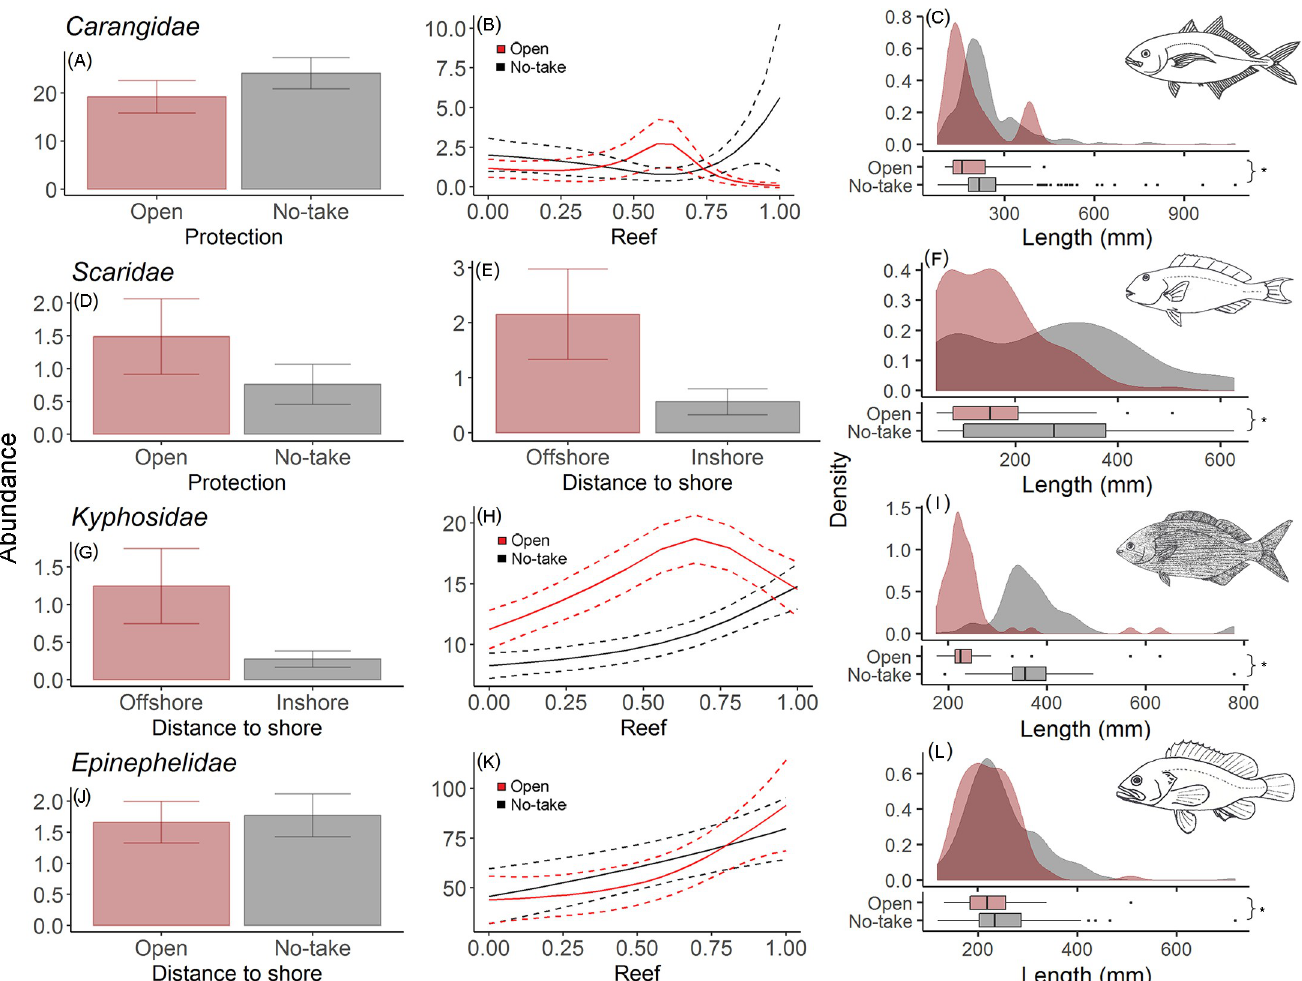
Fig 6. Plots of the most parsimonious models for abundance, Kernel density plots and boxplots for fork length (mm) for important fishing target families. (A, B,C) Carangidae, (D,E,F) Scaridae, (G,H,I) Kyphosidae and (J,K,L) Epinephelidae. The dotted line represents 95% confidence interval. � Significant difference. Fish drawings were based on Carvalho-Filho